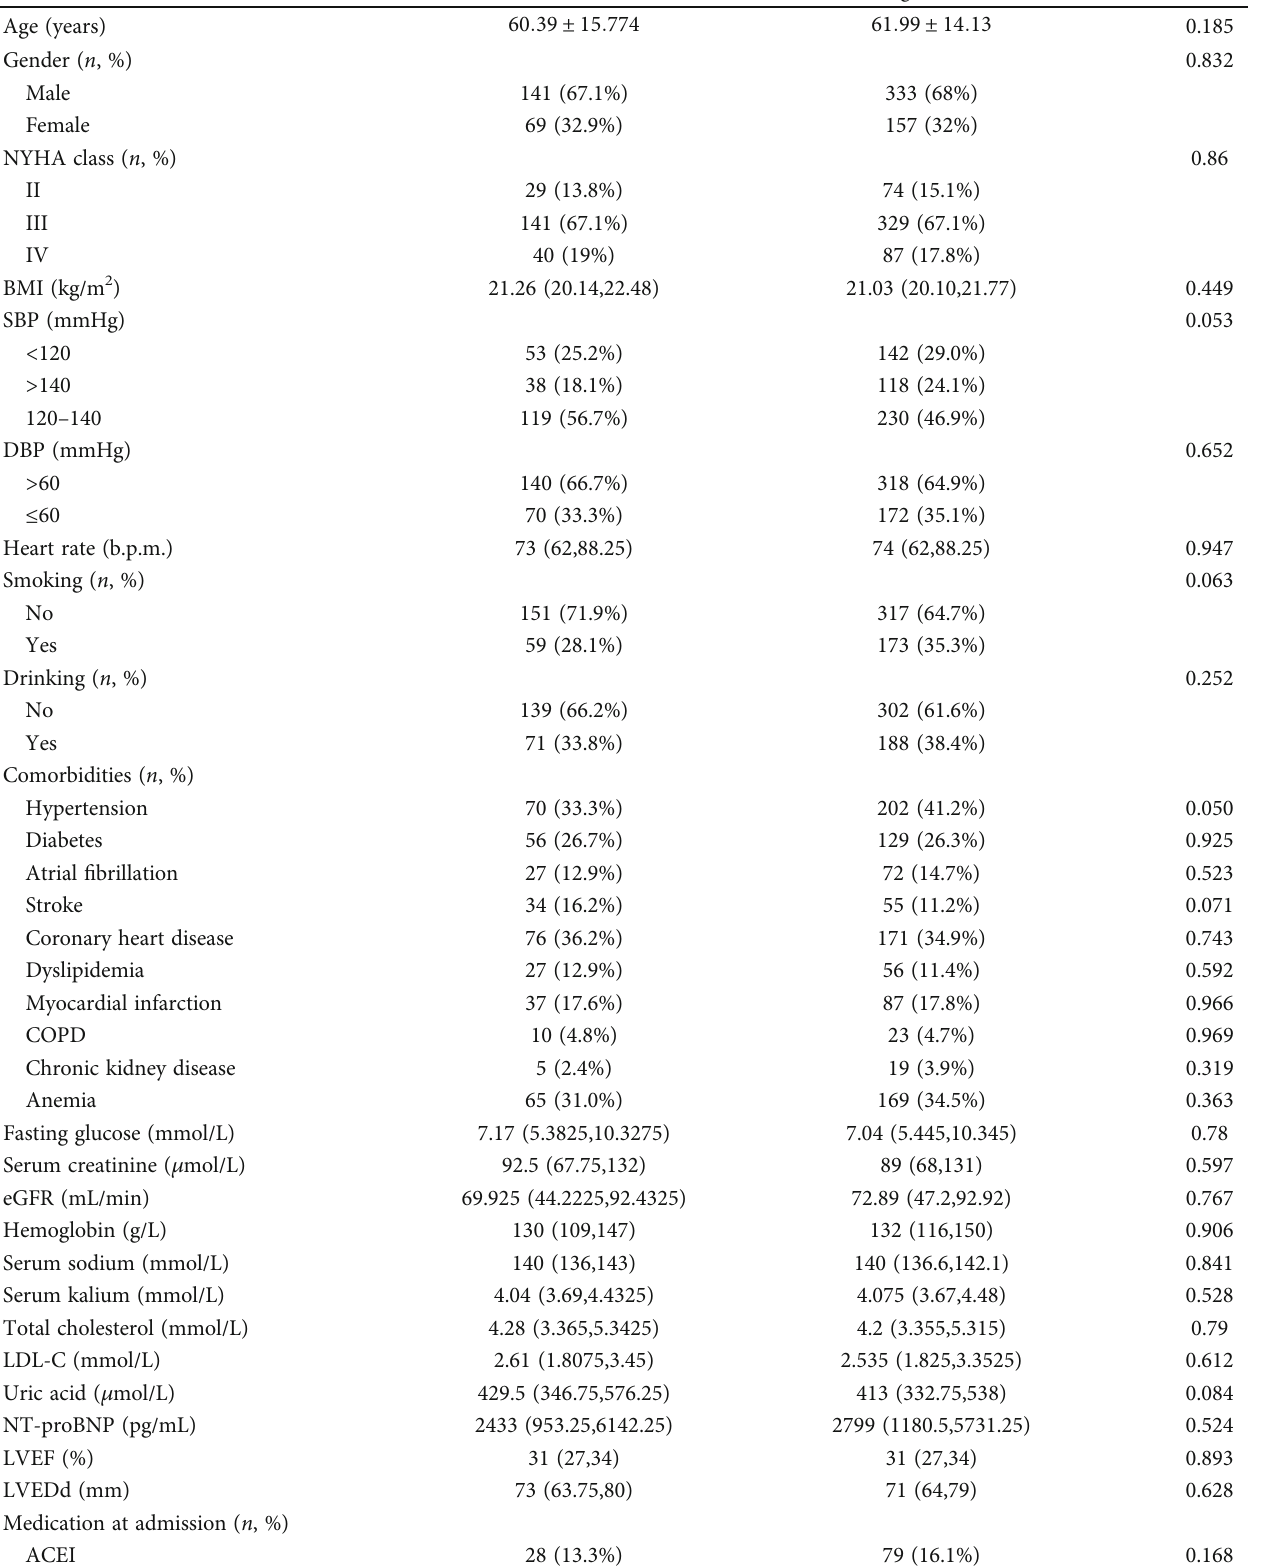
Table 3: Baseline characteristics of validation training